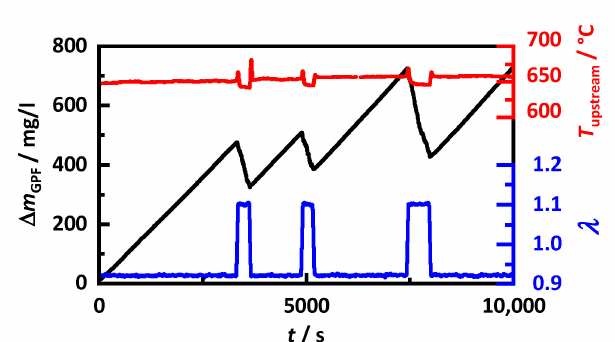
Figure 11. Exhaust gas data during soot loading with multiple partial regenerations caused by switching to lean operation; amount of soot accumulated in the GPF ∆ m GPF (black), temperature T upstream (red) and air-fuel ratio λ (blue) upstream of the GPF.